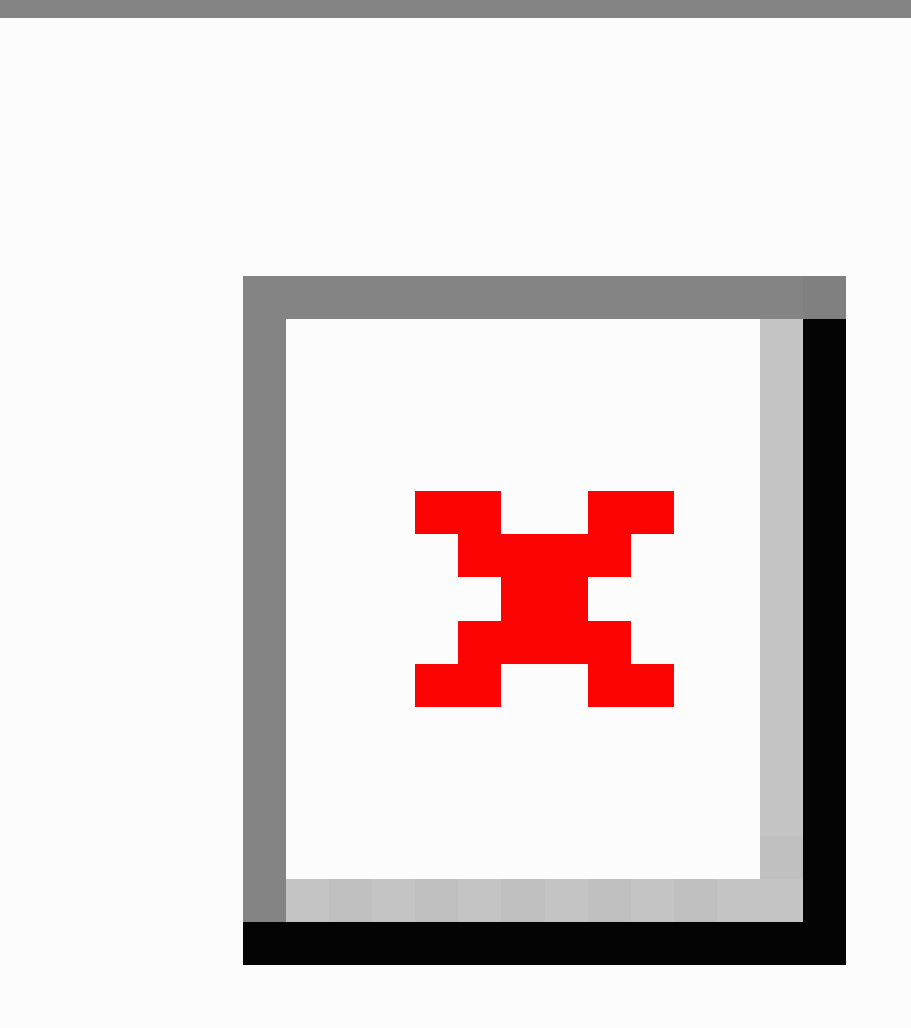
Figure 1. Post by actor axandermery on the social network Alcohol Help